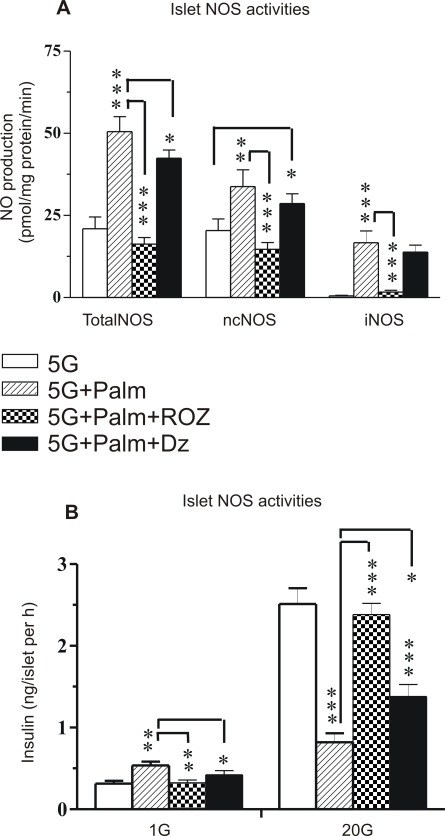
Islet NO generation from neuronal constitutive nitric oxide synthase (ncNOS), inducible NOS (iNOS), and total NOS after culturing with palmitate for 24 h as well as insulin release at basal and high glucose after a subsequent incubation.(A) Total NOS as well as ncNOS and iNOS activities in isolated islets cultured at a basal glucose concentration of 5 mmol/l (5G), 5G+palmitate (1 mmol/l) (Palm), 5G+palmitate+rosiglitazone (1 μmol/l) (Palm+ROZ) or 5G+palmitate+diazoxide (250 μmol/l) (Palm+Dz) (n = 8). (B) Insulin release at low (1 mmol/l) glucose or stimulated by high (20 mmol/l) glucose from islets incubated for 60 min after culturing and washing. The means±s.e.m for 10-12 batches of islets in each group are shown. Asterisks denote probability level of random difference. * P<0.05; ** P<0.01; ***P<0.001.